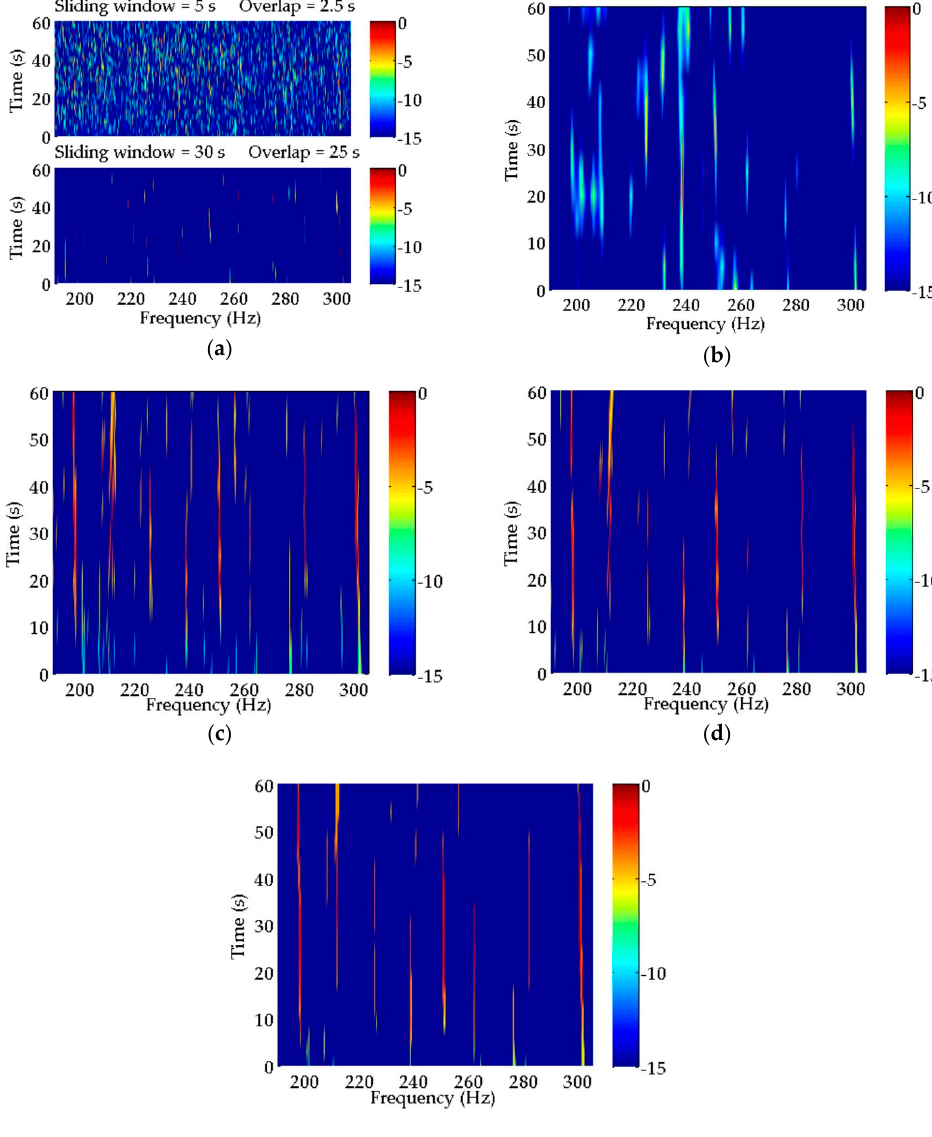
Figure 10. Spectral estimation results of the experimental data obtained by ( a ) CS; ( b ) MUSIC; ( c ) CPSCI; ( d ) CPSII; and ( e ) CCPSCI. Compared with the periodogram, a few discrete spectra can be enhanced